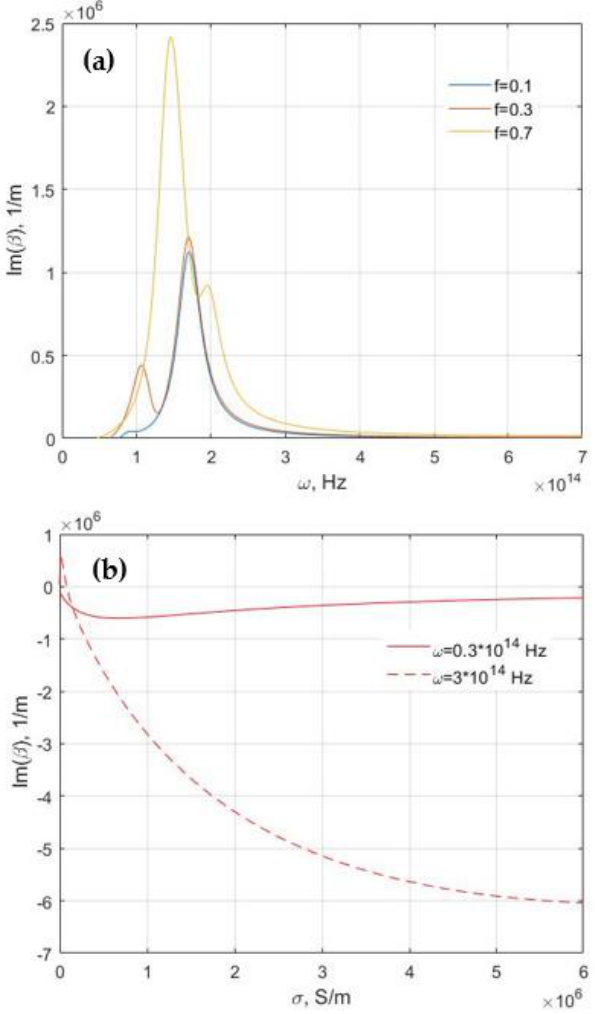
Figure 8. Dependence of imaginary part of propagation constant versus frequency for different filling factors ( a ) and versus conductivity for f = 0.3 ( b ). ε n = 11.8, ε d = 2.25. All the presented results are obtained for the ITO inclusions.